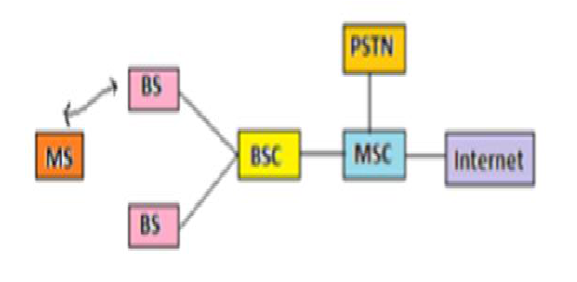
Figure 2. Architecture of Advance Mobile Phone Services